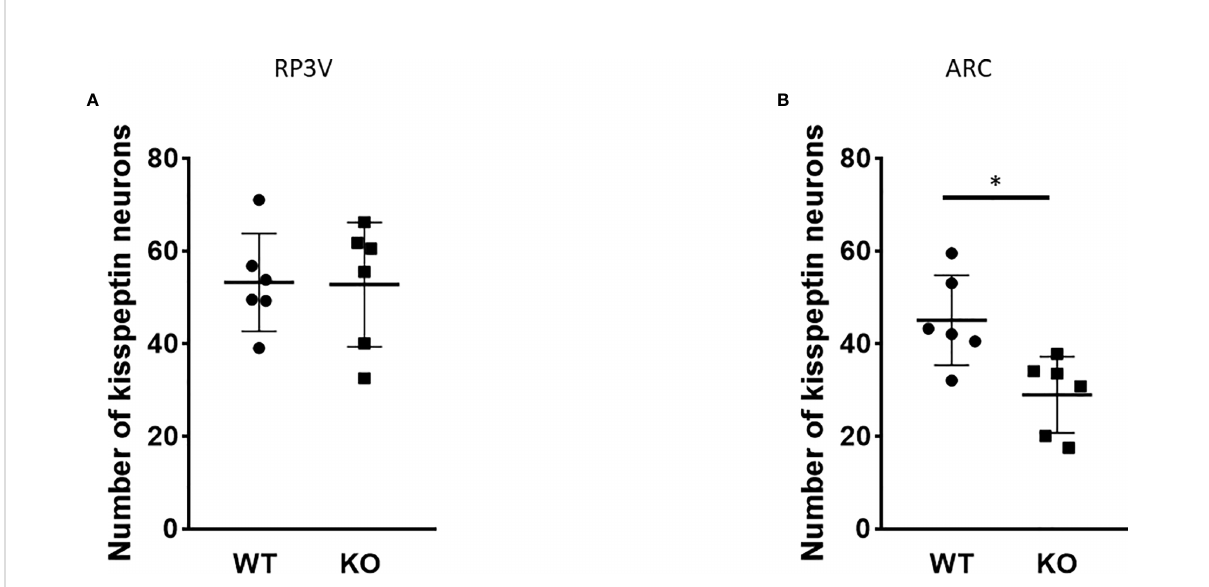
FIGURE 7 Number of Kiss1 mRNA-positive neurons in the RP3V and ARC in wild-type and PACAP KO female mice. Summarized data of RNAscope in situ hybridization experiments are shown in dot plots. The number of Kiss1 mRNA-positive cells is shown in RP3V (A) and ARC (B) from wild-type and PACAP KO female mice (two slices per animal, six animals in both groups). Data are presented as mean ± SD, * p <